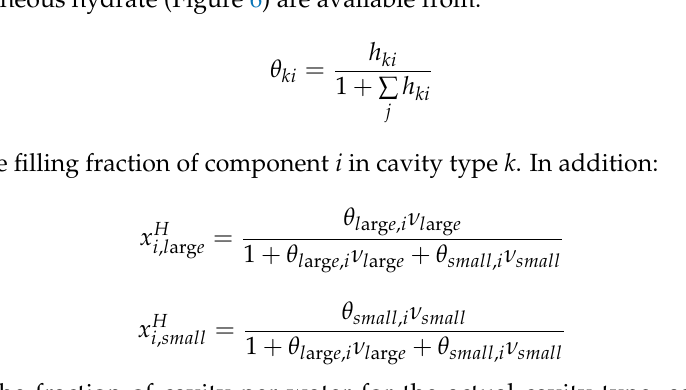
Figure 8. Chemical potential for methane in hydrate formed heterogeneously from water and CH 4 gas (solid) and chemical potential for methane in hydrate formed homogeneously from dissolved CH 4 in water (dashed).